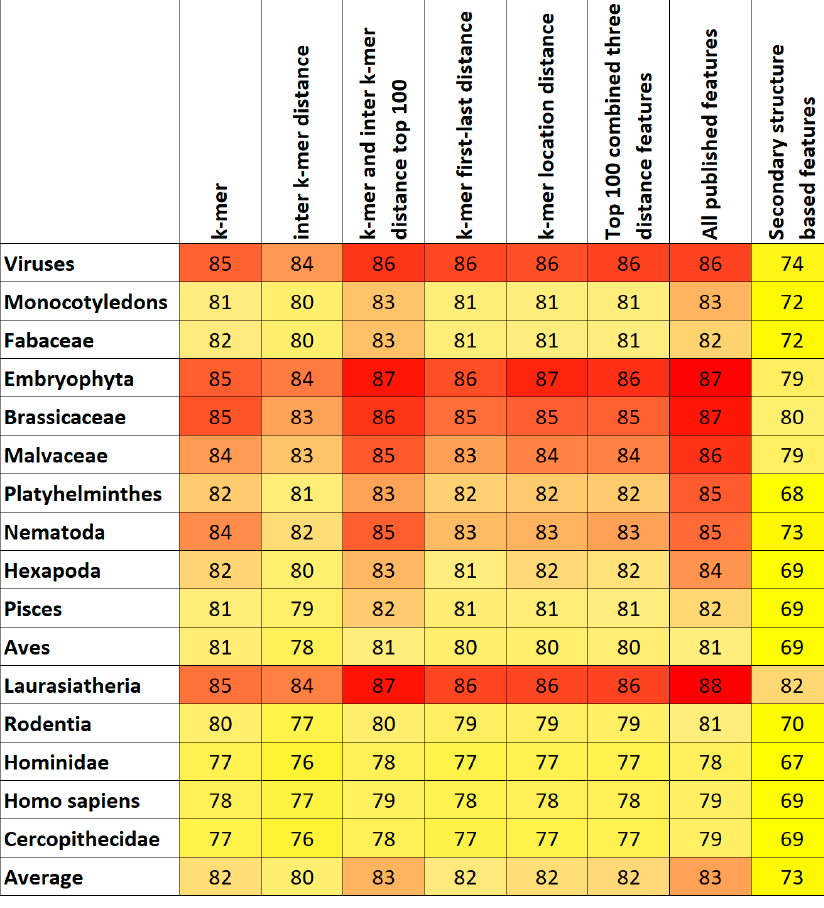
Figure 9. Summary of the results from Figures 3–5, 7, and 8. Yellow shades indicate lower accu- racy, while red shades show higher average classification accuracy. while red shades show higher average classification